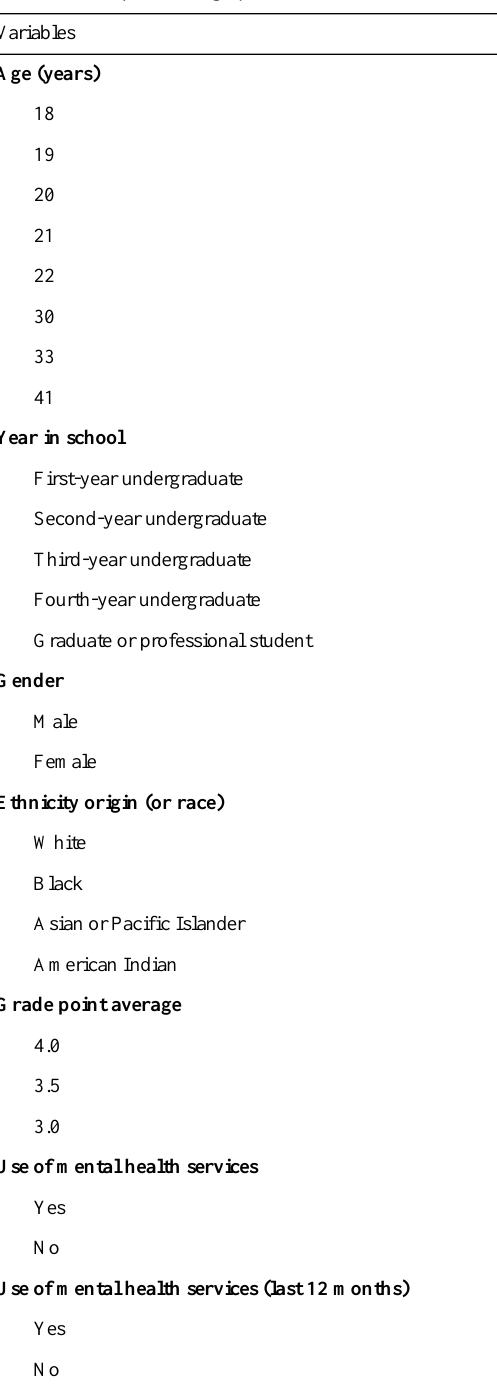
Table 1. Participant demographics